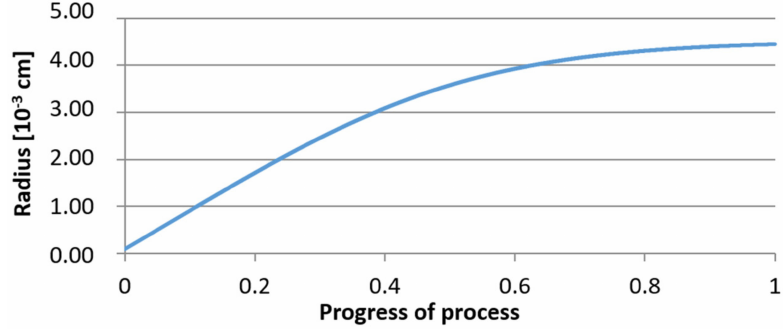
Figure 20. Growth of the radius of nucleus (with an initial radius r 0 = 1 µ m) in steel 2.